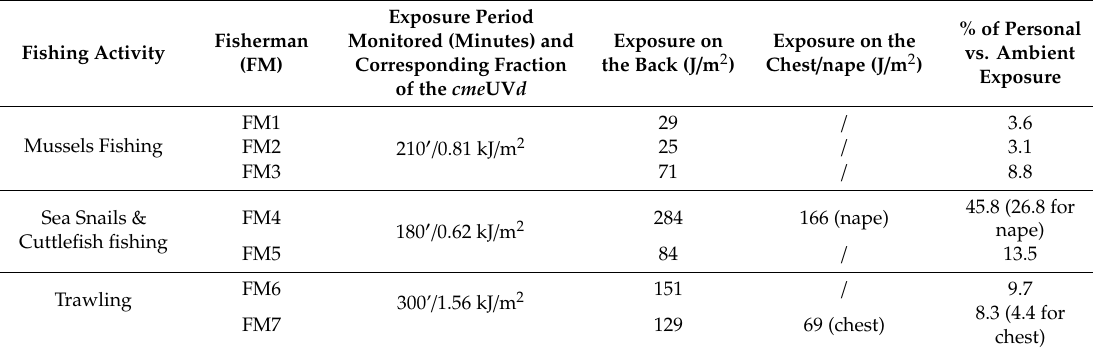
Table 3. Individual solar UV exposure measured for the seven fishermen on the second day